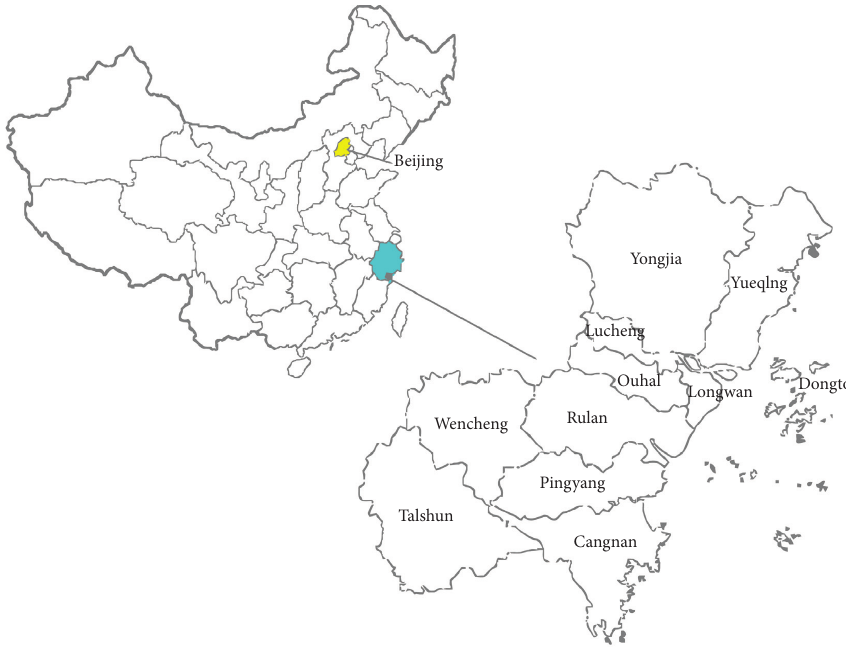
Figure 1: The specific geography location of Wenzhou city, including 10 districts’ county-level cities/counties [6].